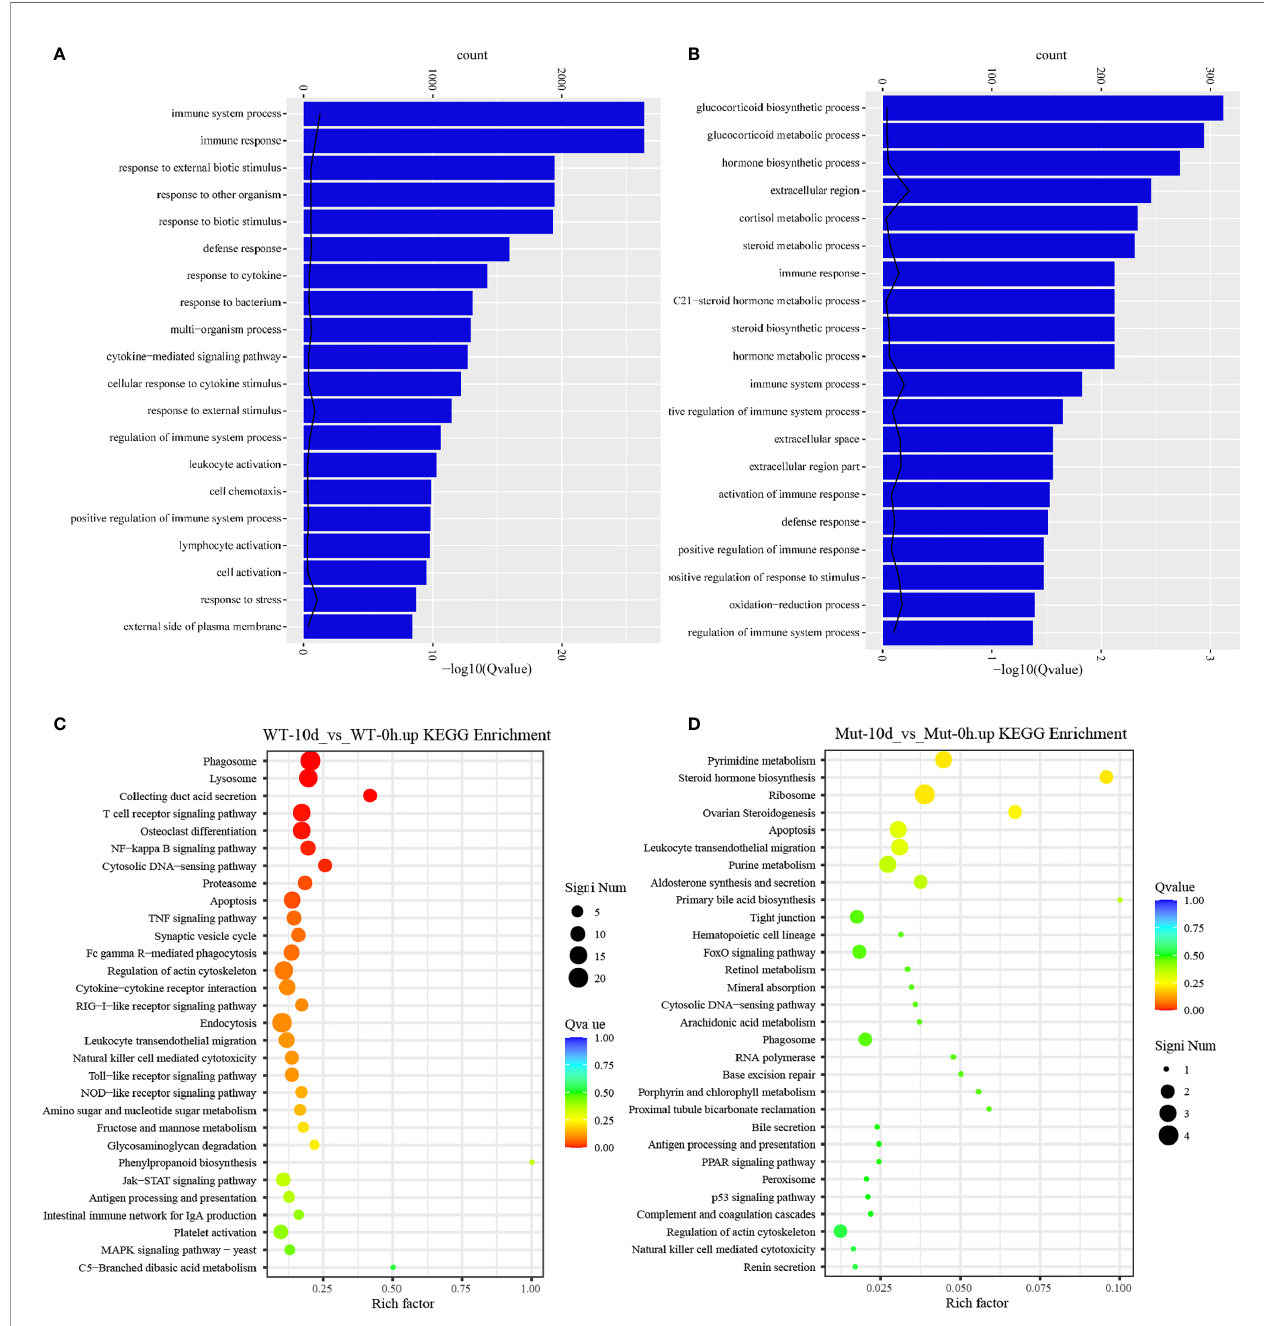
FIGURE 5 | GO functional enrichment and KEGG analysis from upregulated DEGs in WT-10d_vs_WT-0h and Mut-10d_vs_Mut-0h. (A, B) The top 20 signi fi cantly upregulated GO categories in WT-10d_vs_WT-0h and Mut-10d_vs_Mut-0h, respectively. The X - and Y -axes represent the signi fi cantly enriched GO terms and the corresponding number of DEGs, respectively. (C, D) The top 30 upregulated KEGG pathways in WT-10d_vs_WT-0h and Mut-10d_vs_Mut-0h, respectively. The numbers of DEGs in each pathway are counted, and rich factors and P -values are